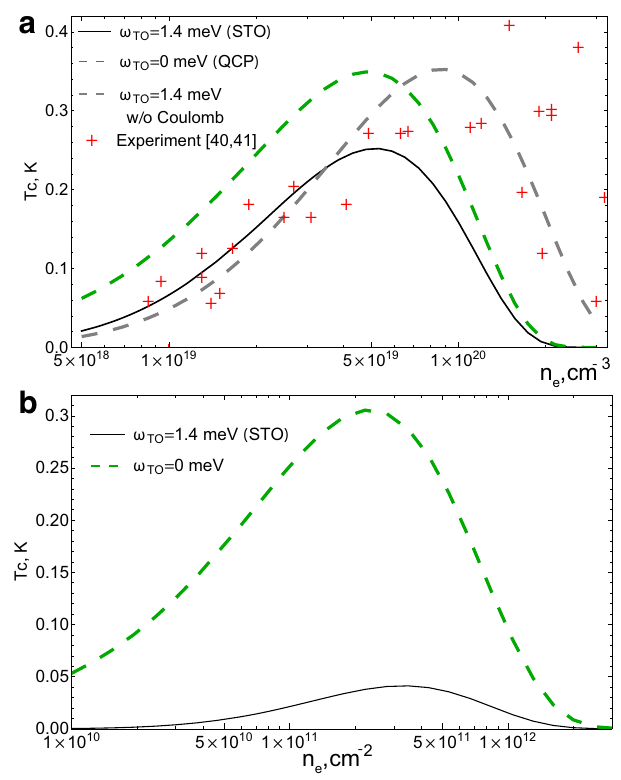
Fig.3|Superconducting T c fortheenergy- fl uctuationmechanismasafunction of electron density. a Black solid line: T c as a function of carrier density for parameters appropriate for SrTiO 3 , where the best fi t is obtained for g = a 3 0 =0 : 68. The experimental T c is determined from the onset of the Meissner effect 39,40 . The green line shows the T c ( n e ) expected at the QCP. The gray dashed line shows the best fi tfor T c ( g = a 3 0 =0 : 62)iftheeffectsofCoulombrepulsionareignored. b Same as ( a ) for a 2D system modeling a fi lm of SrTiO 3 with thickness 2 a 0 . m * =1.8 m e is takendue to low densities 41 . The enhancement dueto proximitytothe QCP(green line) is much stronger, than in the 3D case ( a